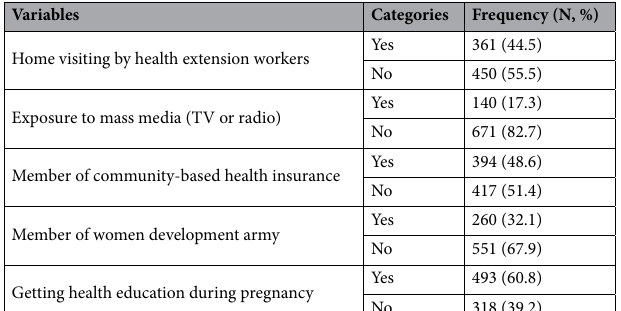
Table 1. Sociodemographic demographic characteristics of delivered mothers in Northwest Ethiopia, 2020. Source of information and community participation of the study participants.